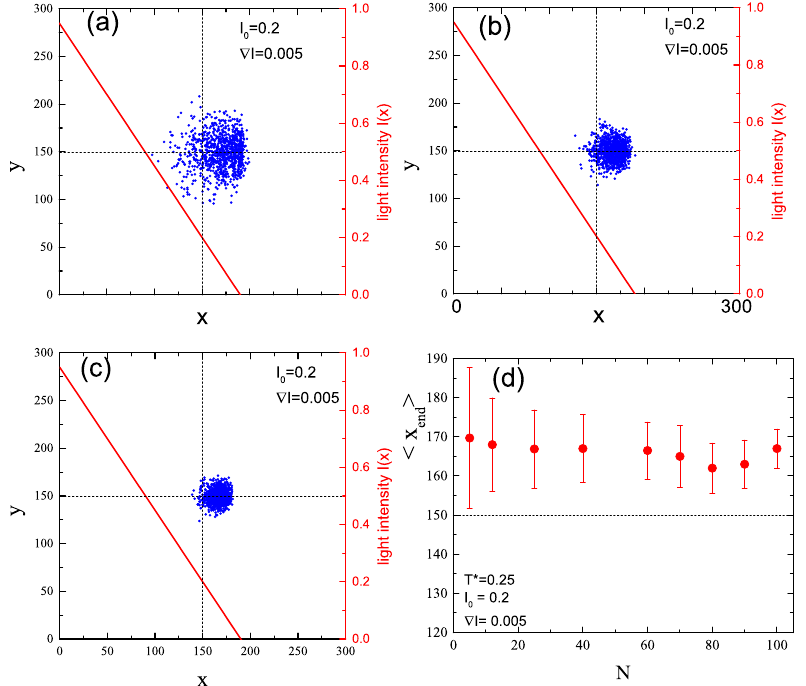
Figure 10. Projection of CM of 10 3 chains onto x − y plane at the end of the simulation for I 0 = 0.2, ∇ I = 0.005 and different number of monomers: N = 5 ( a ); N = 25 ( b ); and N = 60 ( c ). Averaged displacement < x end > of CM of chains in x direction and its standard deviation as a function of N ( d